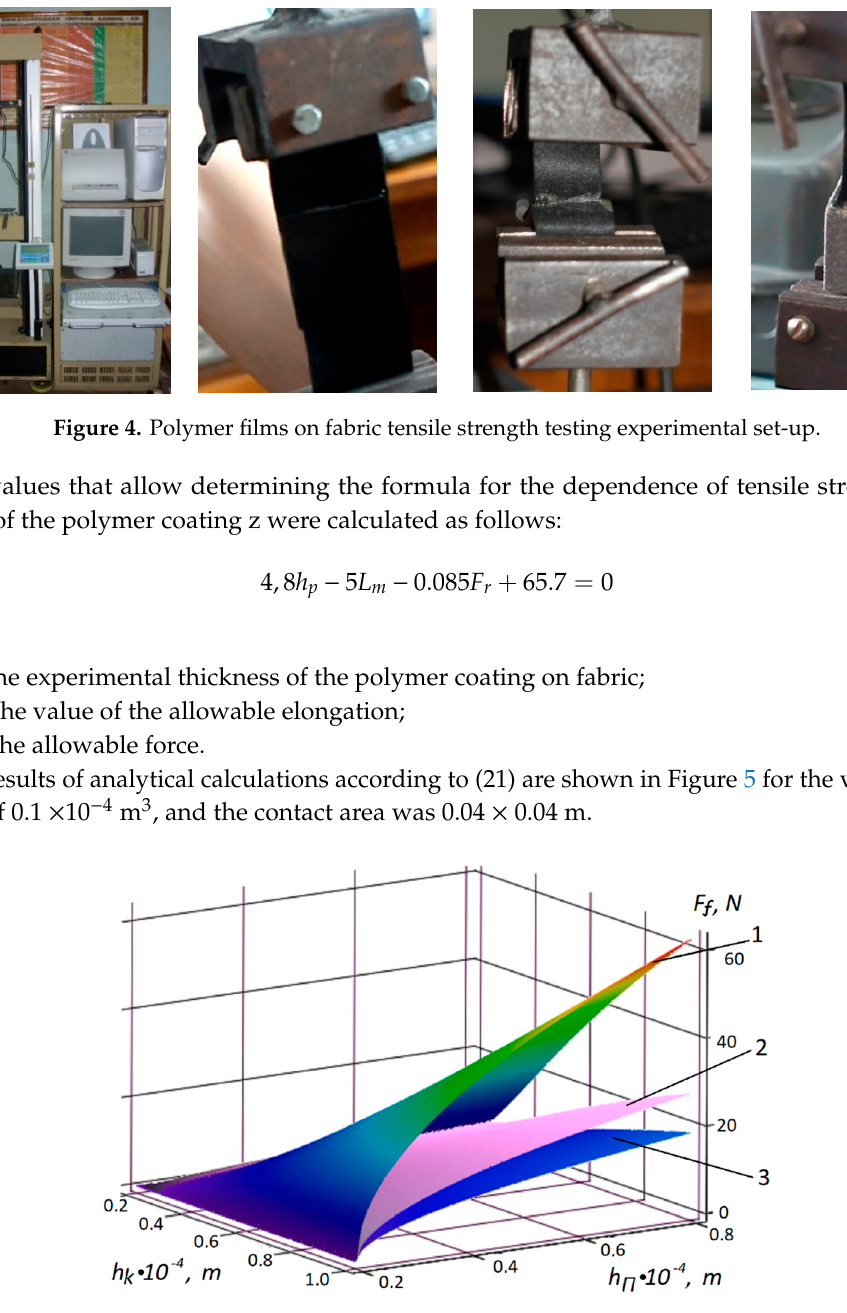
Figure 5. Dependences of the polymer coating thickness h k and of capillary penetration h π polymer on the tensile strength F t for (1) fabric denim, (2) genuine beef skin, and (3) artificial leather SK-2.